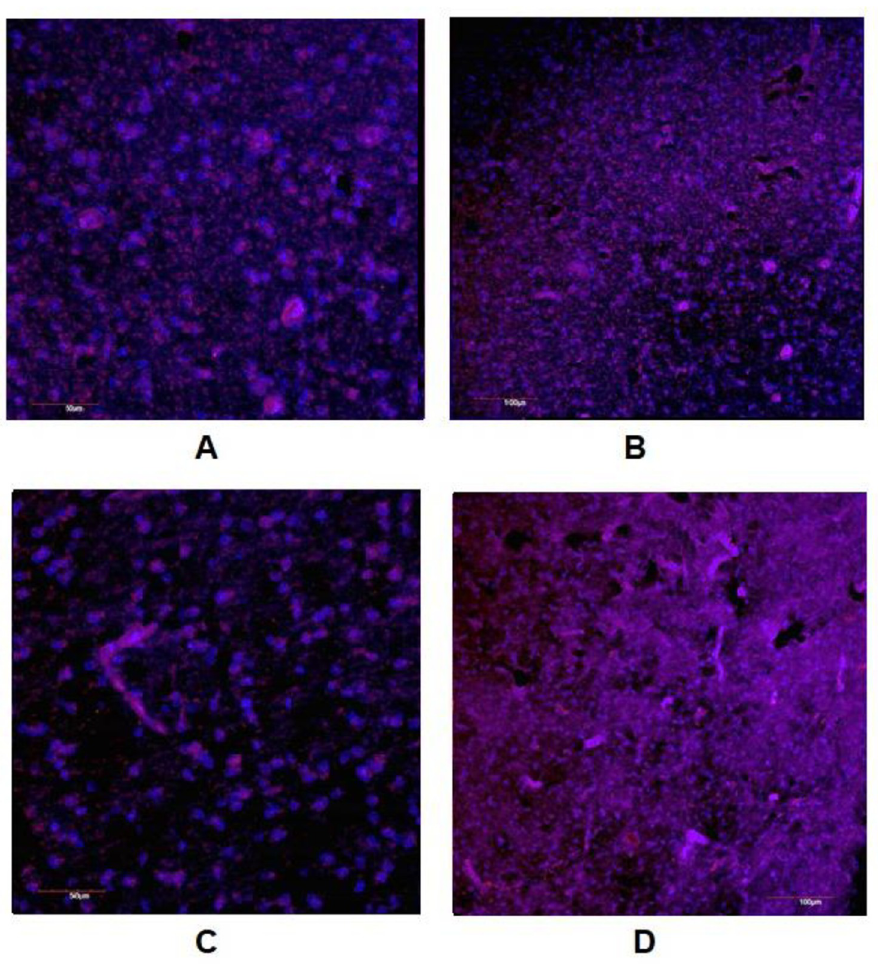
Fig 5. Expression of receptors for melatonin 1 (RMt1) and 2 (RMt2) in the medulla, х 400. Immunofluorescent staining with antibodies to melatonin 1 and 2 receptors (red fluorescence), Hoechst nuclear stain (blue fluorescence), х 400. A—infants with SIDS, RMt1, B—the control group RMt1, C—infants with SIDS, RMt2, D—the control group RMt2.